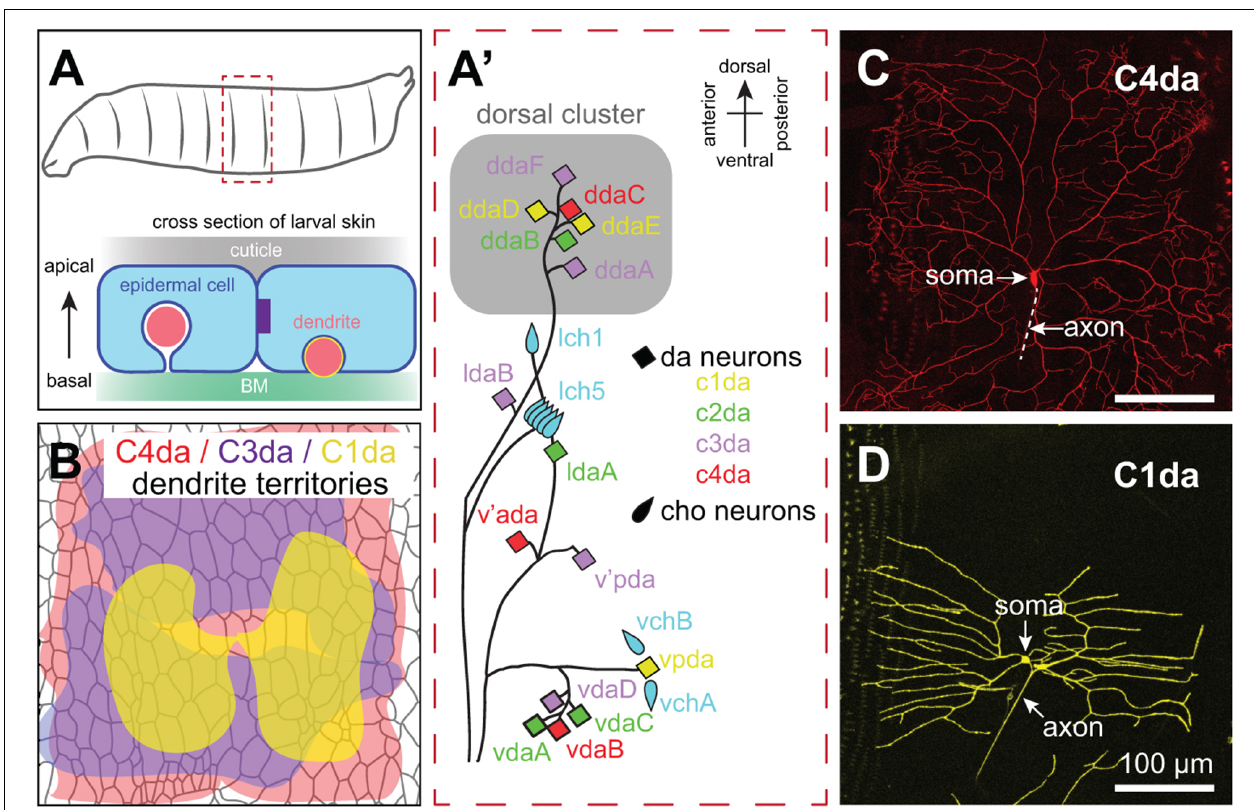
FIGURE 2 | Anatomy of Drosophila SSNs and skin. (A) Organization of the larval abdominal peripheral nervous system (PNS) depicting neurons discussed in this review (left) and cross-sectional view depicting the relative position of epidermal cells, apical cuticle, basement membrane (BM), and SSN dendrites (right). Note that es neurons and subsets of md neurons are omitted from the schematic. (B) Peripheral territories of Drosophila SSNs. Schematic depicts dendritic territories of C4da (nociceptors, red), C3da (gentle touch receptors, purple), and C1da (proprioceptors, yellow) neurons and distribution of epidermal cells in a representative abdominal hemisegment. Schematic adapted from Grueber et al. (2002) and Parrish et al. (2009). (C,D) Confocal micrographs of representative (C) C4da and (D) C1da neurons are shown. Image credits: C4da neuron (Peng et al., 2015); C1da neuron (Lin et al., 2015) under the Creative Commons